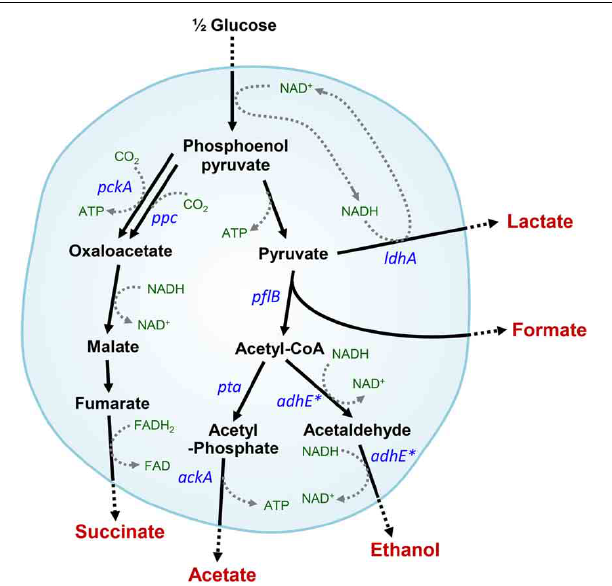
FIGURE 1 | Intracellular anaerobic NAD + recycling in mixed acid fermentation by lactate dehydrogenase in (cid:2) adhE mutant cells. Metabolic pathways affected by the adhE mutation are indicated by